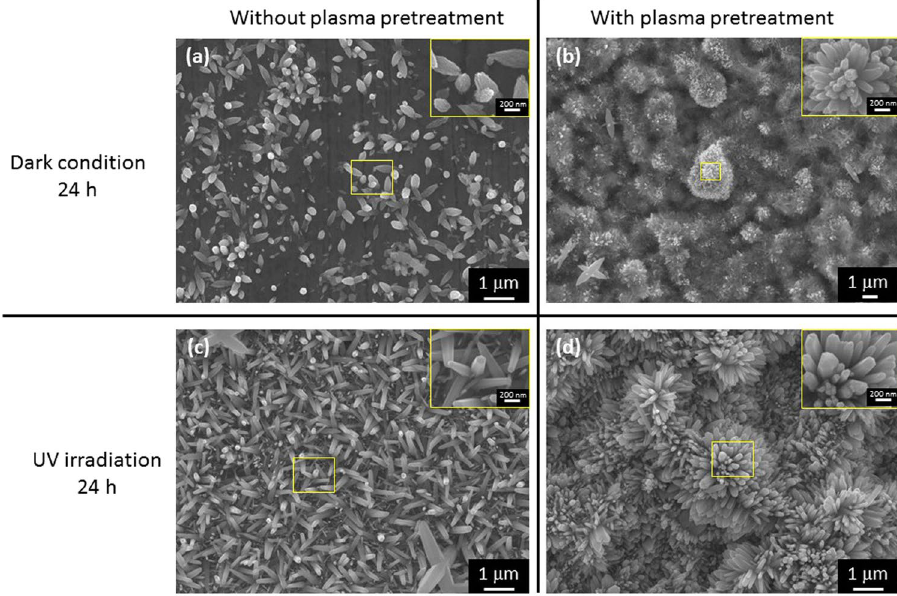
Figure 6. SEM images of the Zn plate: ( a ) untreated specimen in dark conditions for 24 h, ( b ) plasma- pretreated specimen in dark conditions for 24 h, ( c ) untreated specimen after UV irradiation for 24 h, and ( d ) plasma-pretreated specimen after UV irradiation for 24